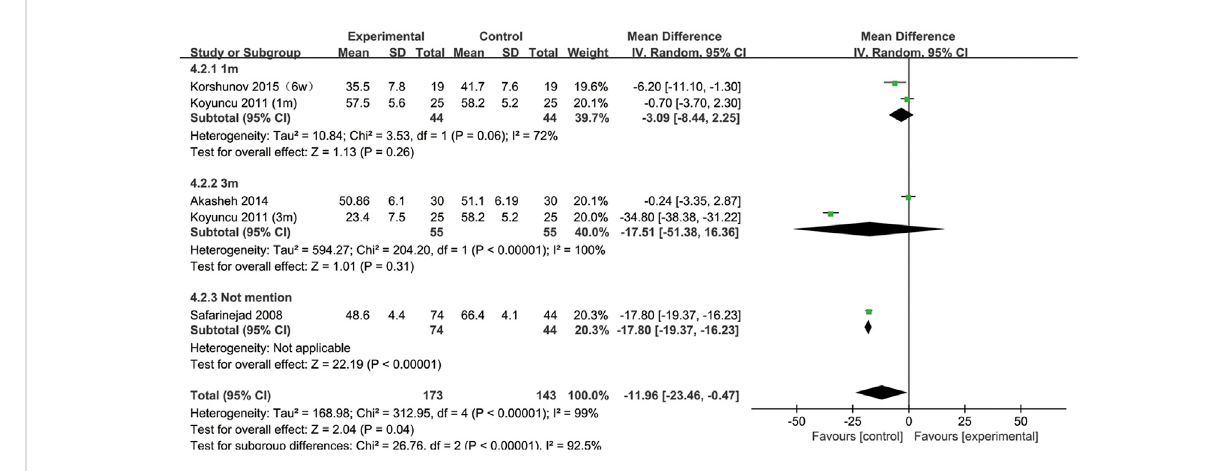
Subgroup of the association between sperm motility and different SSRIs treatment duration.